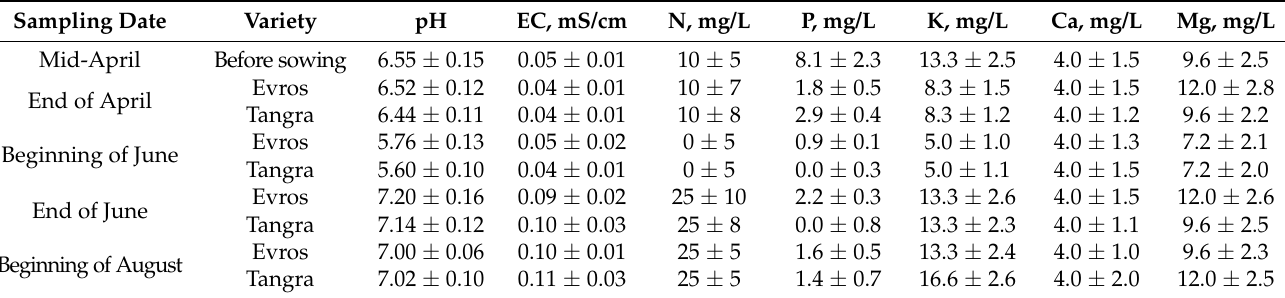
Table 5. Soil analyzes during growing seasons of two bean varieties grown in organic field. Data are presented as average from three years ± standard deviation.